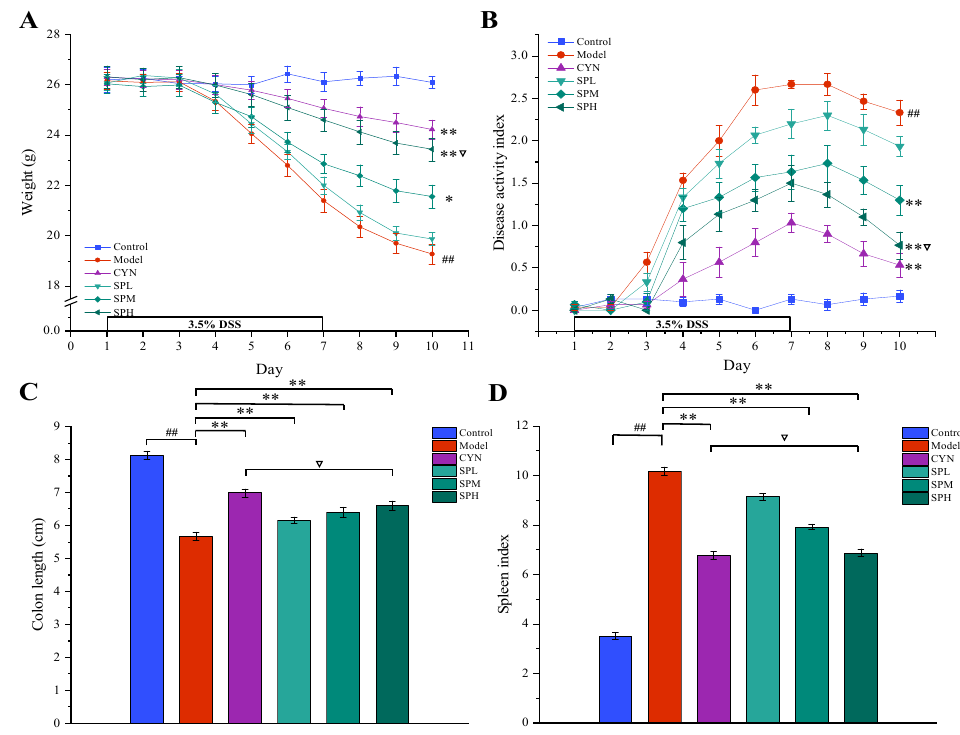
Figure 3. Effect of SP on ( A ) body weight, ( B ) disease activity index, ( C ) colon length and ( D ) spleen coefficient. (Data are expressed as the means ± S.E.M., n = 10). Compared with control group, ## p < 0.01; compared with model group, * p < 0.05, ** p < 0.01; compared with CYN group, ∇ p > 0.05).